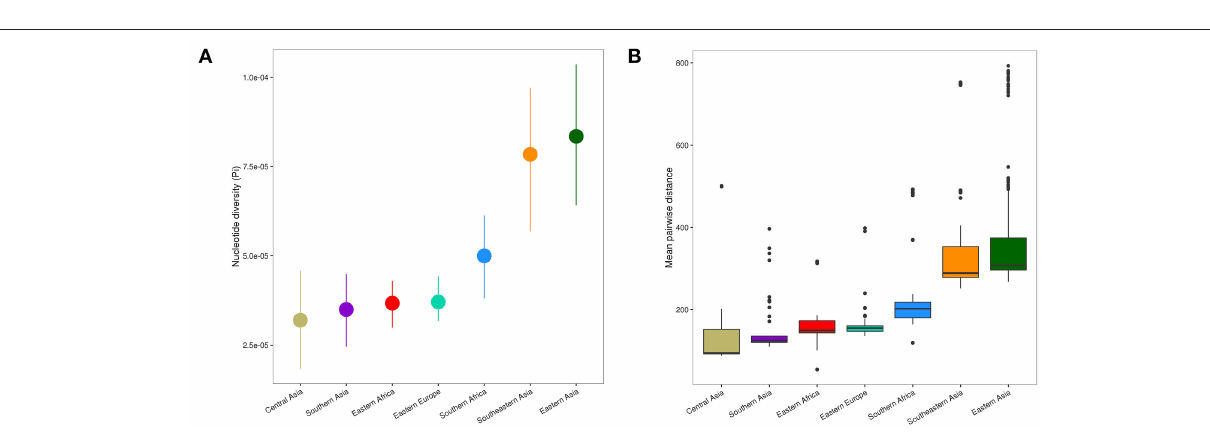
FIGURE 3 | Genetic diversity of L2 strains within geographical regions. (A) Nucleotide diversity ( π ) per site of L2 strains by geography. Error bars are the 95% confidence intervals obtained by bootstrapping. (B) Pairwise genetic SNP distance of L2 by geography ( p- values were obtained from Wilcoxon rank-sum tests). Each box represents the 25% and 75% quartiles and the line denotes the